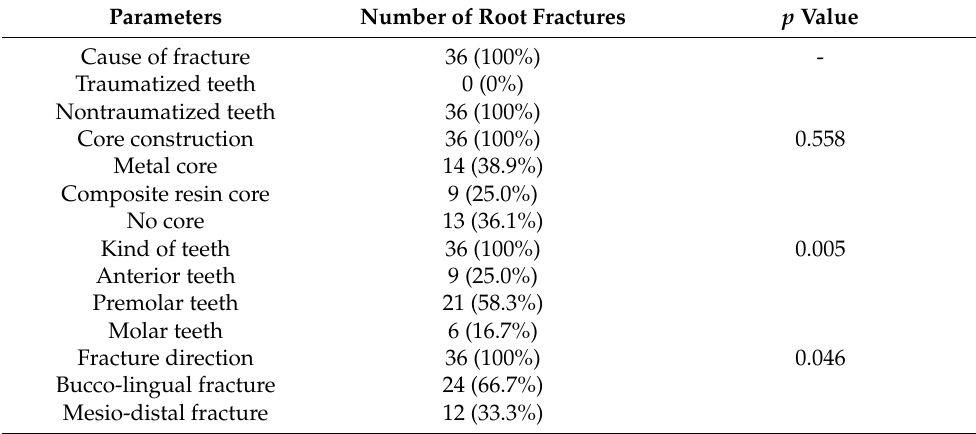
Table 2. Characteristics of 36 vertical root